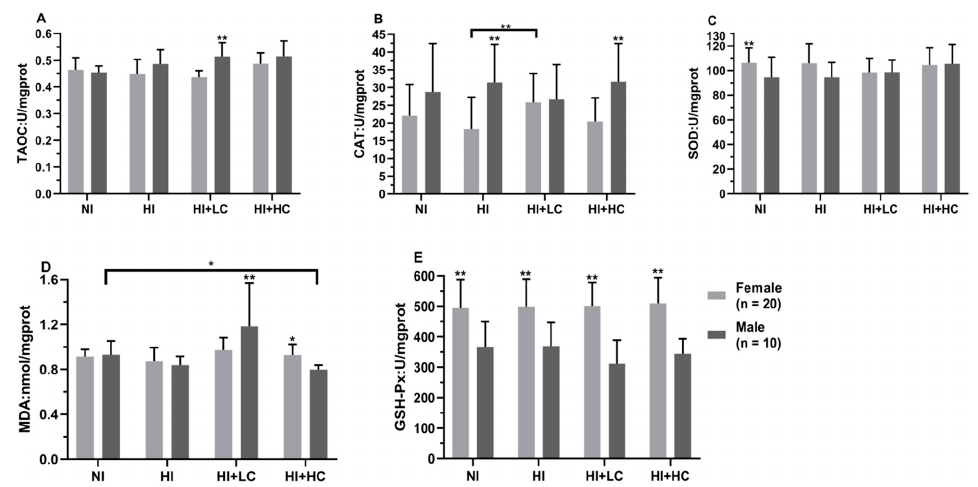
Figure 2. Protection of vitamin C from oxidative damage in liver for different sexes. ( A ) The activity of TAOC; ( B ) The activity of CAT; ( C ) The activity of SOD; ( D ) The content of MDA; ( E ) The activity of GSH-Px. All data are presented as mean and standard deviation. ** represents p < 0.01, and * represents p < 0.05. Table 2. Protection of vitamin C from oxidative damage in liver.